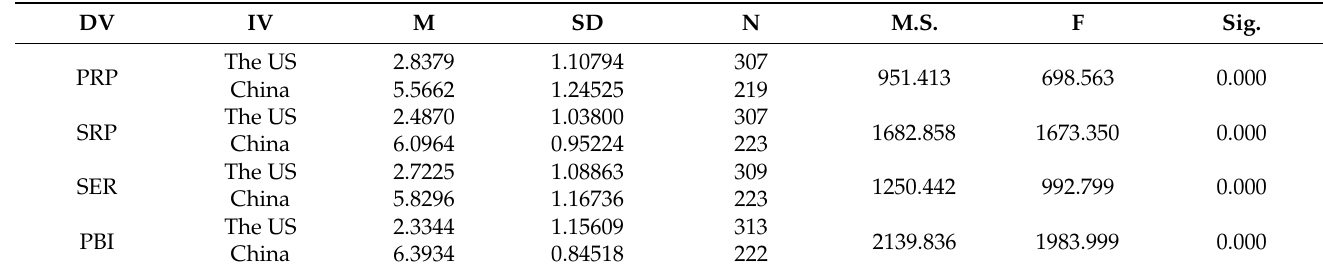
Table 6. Health perception differences between the US and China.